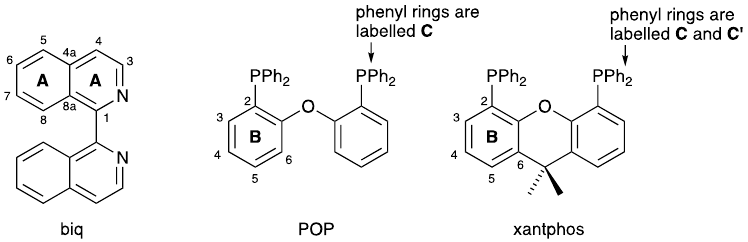
Scheme 2. Structures of 1,1'-biisoquinoline (biq), bis(2-(diphenylphosphanyl)phenyl)ether (POP), and (9,9-dimethyl-9 H -xanthene-4,5-diyl)bis(diphenylphosphane) (xantphos) with atom labelling used for NMR spectroscopic assignments.